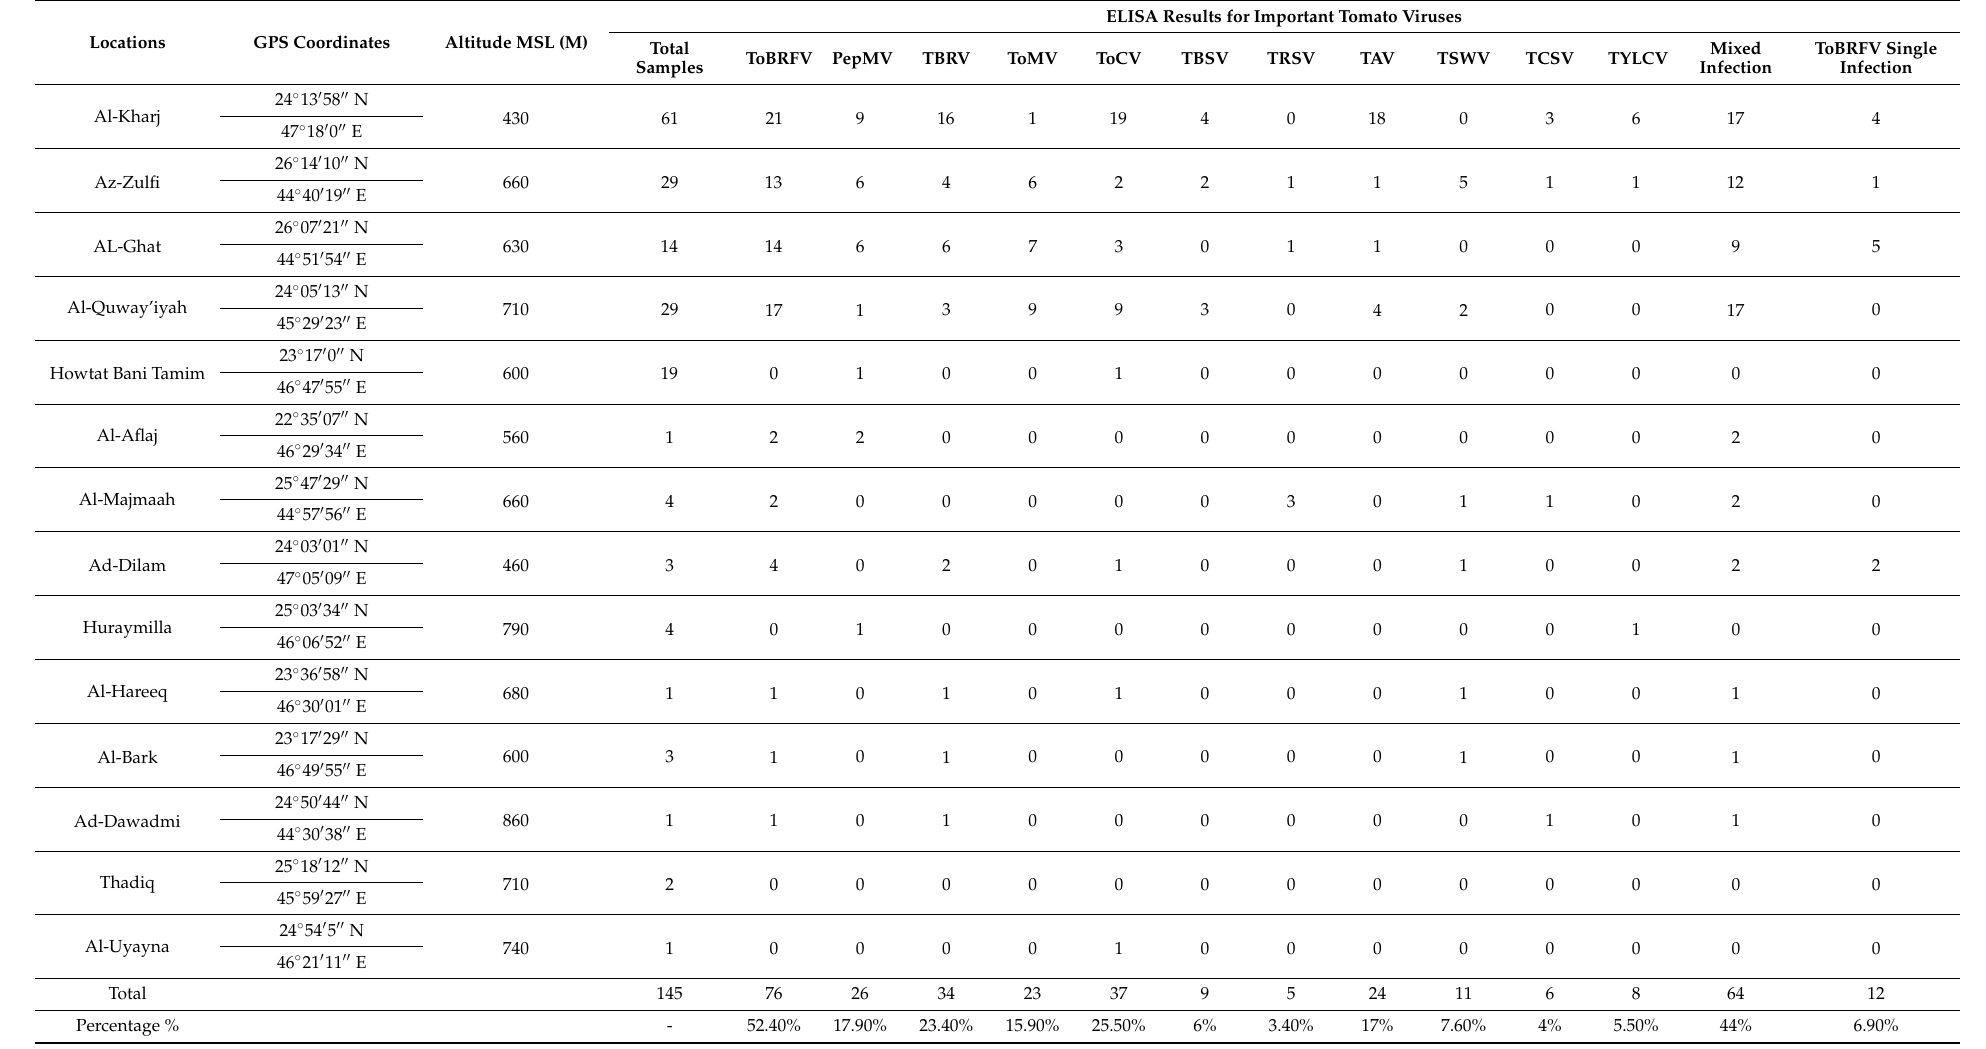
Table 1. Detection of tomato viruses in tomato samples collected from different locations in Riyadh